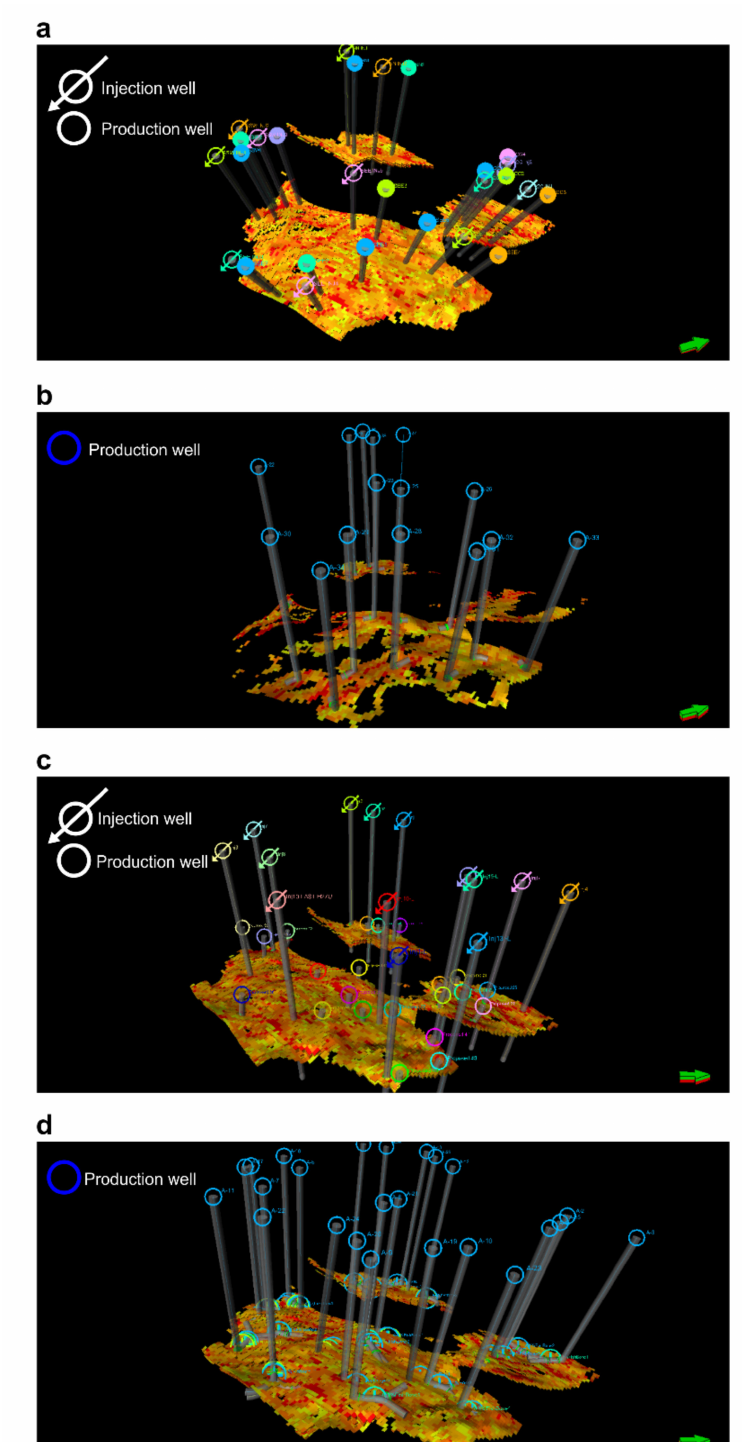
Figure 9. Planned well design and placement. ( a ) Vertical well placement, ( b ) horizontal well placement, ( c ) highly deviated well placement, and ( d ) multilateral well